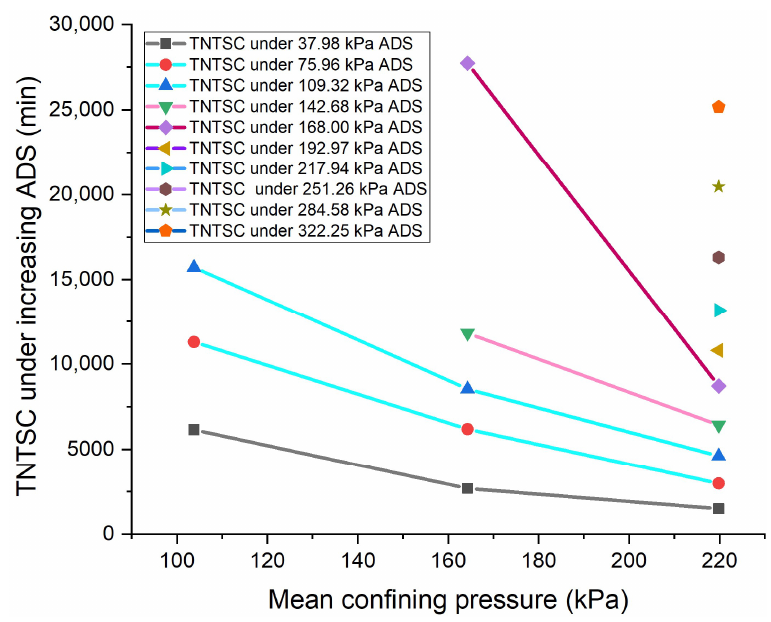
Figure 40. The time needed until stable creep under the preset axial deviatoric stresses withstanding different confining pressures.